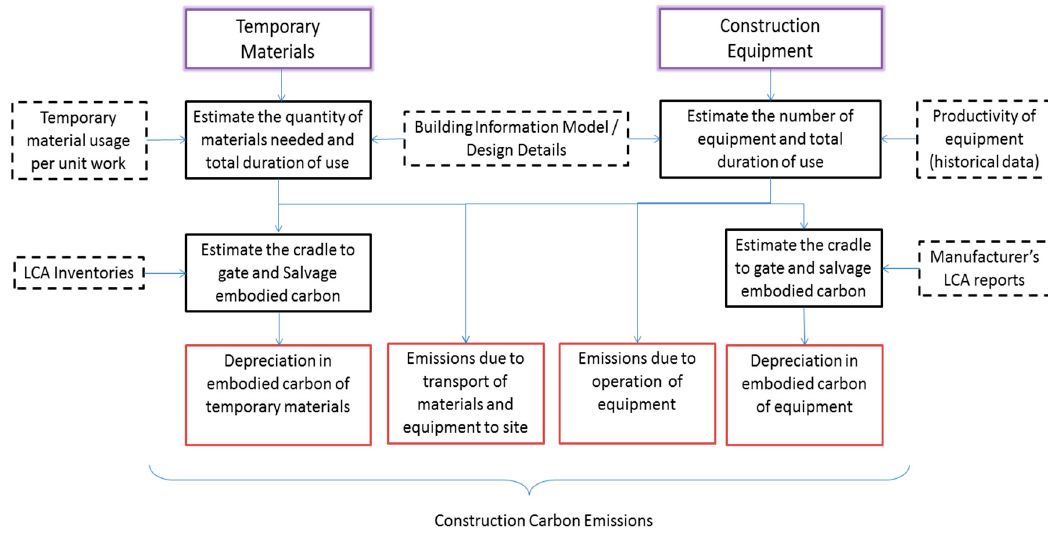
Figure 3. A framework for the estimation of carbon emissions incurred during the construction phase.